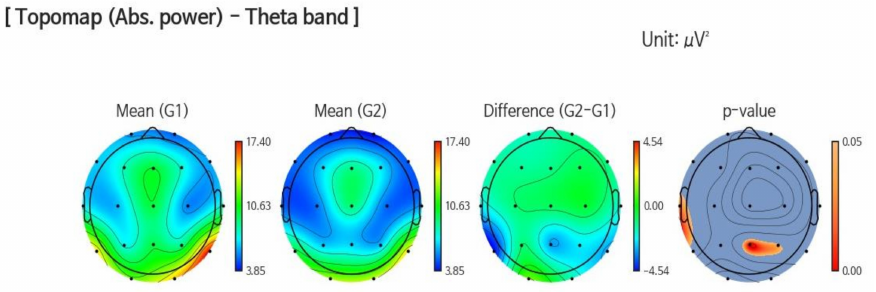
Figure 3. This figure shows a significant decrease in Theta power in the parietal ( p = 0.013) and temporal areas ( p = 0.036) at follow up (G2) compared to baseline (G1) in the VR intervention